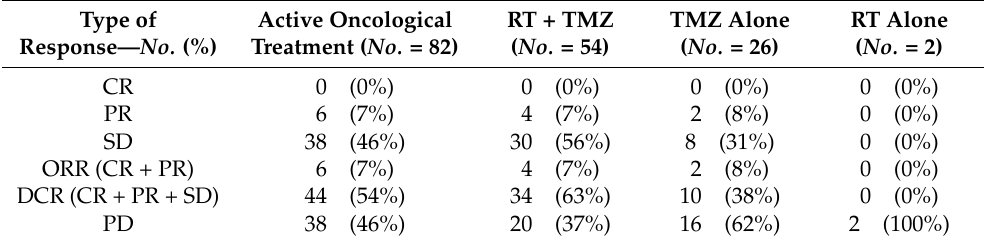
Table 2. Best response to treatment according to the RANO criteria.